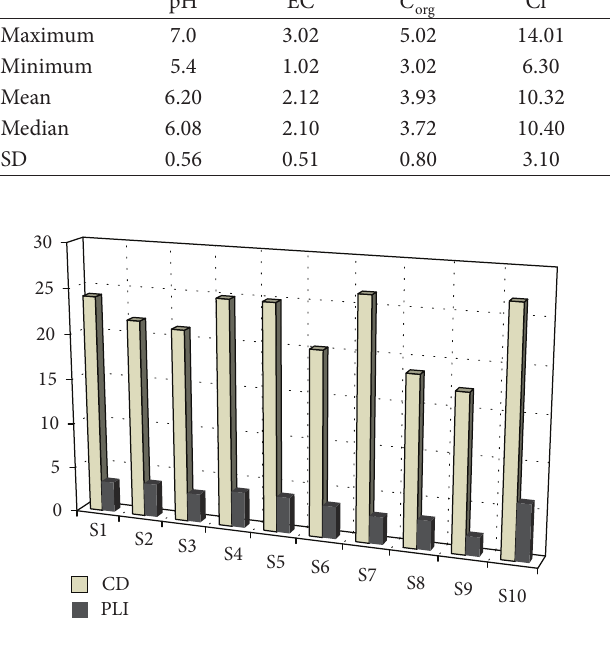
F 3: Contamination degree (CD) and pollution load index (PLI) of the analyzed soil